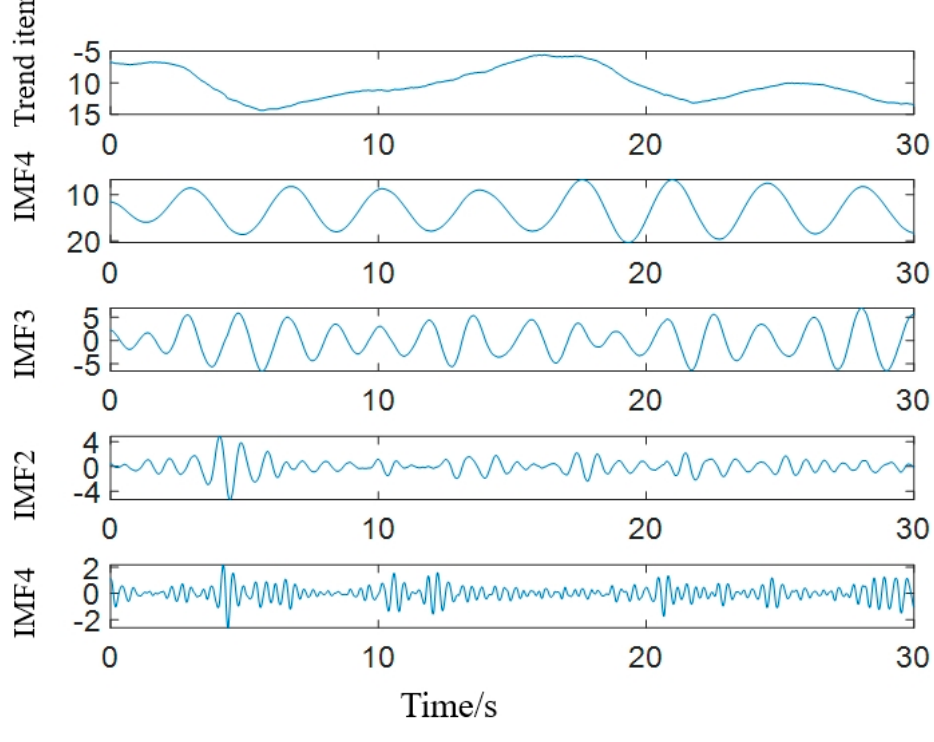
Figure 5. Results of VMD decomposition.